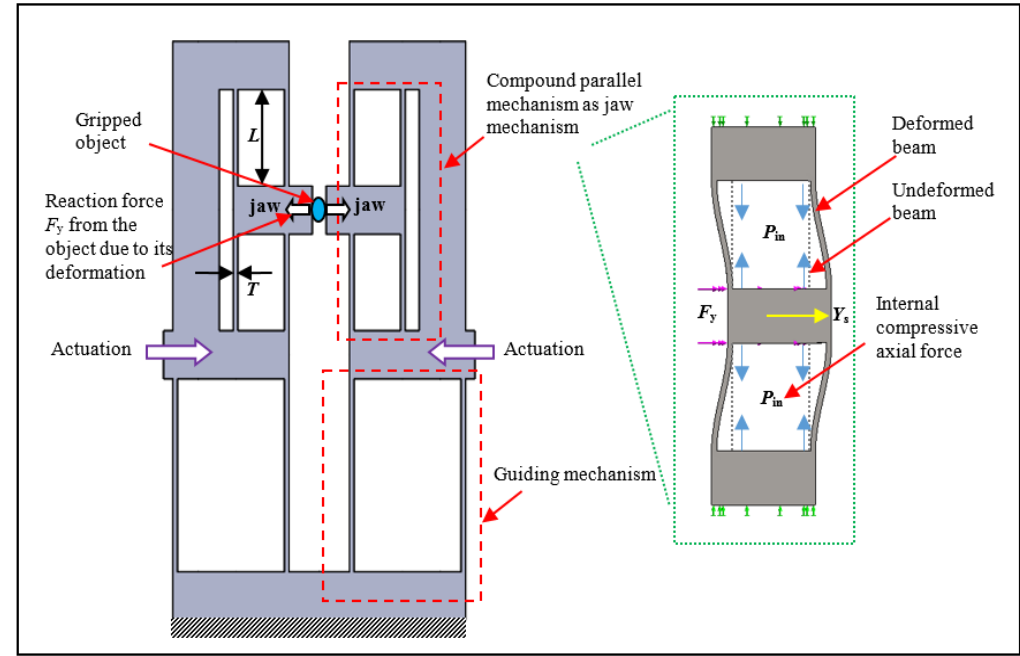
Figure 1. Schematic design of the proposed monolithic symmetrical gripper.